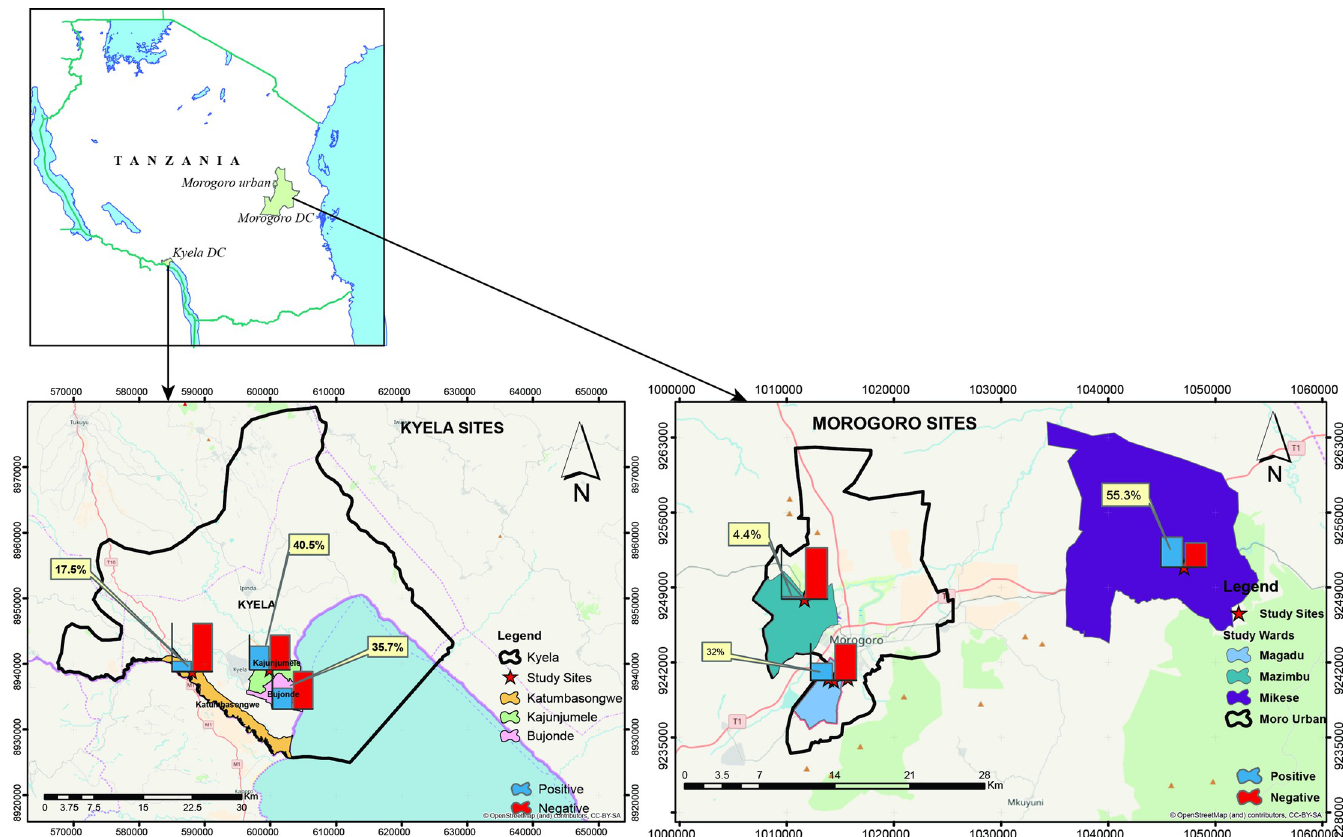
Fig 1. Seroprevalence of RVFV in cattle from different wards in Kyela and Morogoro districts.